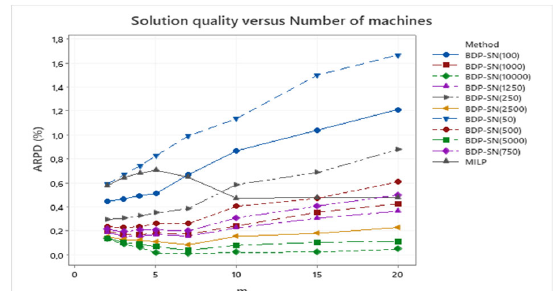
Fig. 13. ARPD variation with respect to the number of ma- chines for the second experimental set